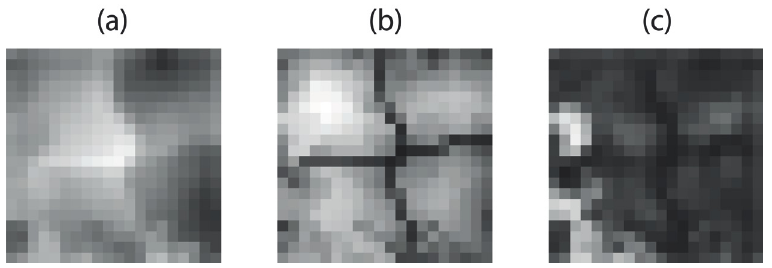
Fig. 6. PDF estimation with